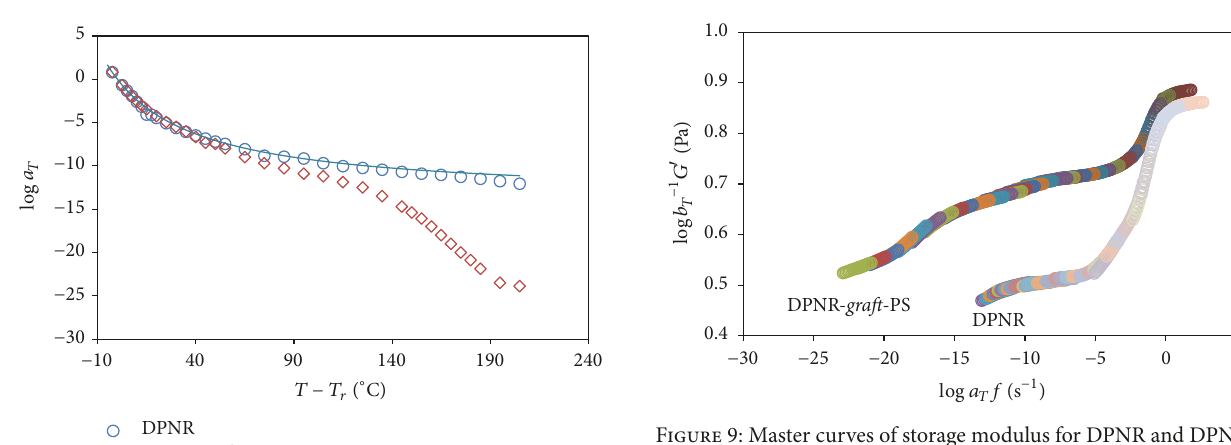
Figure 9: Master curves of storage modulus for DPNR and DPNR- graft